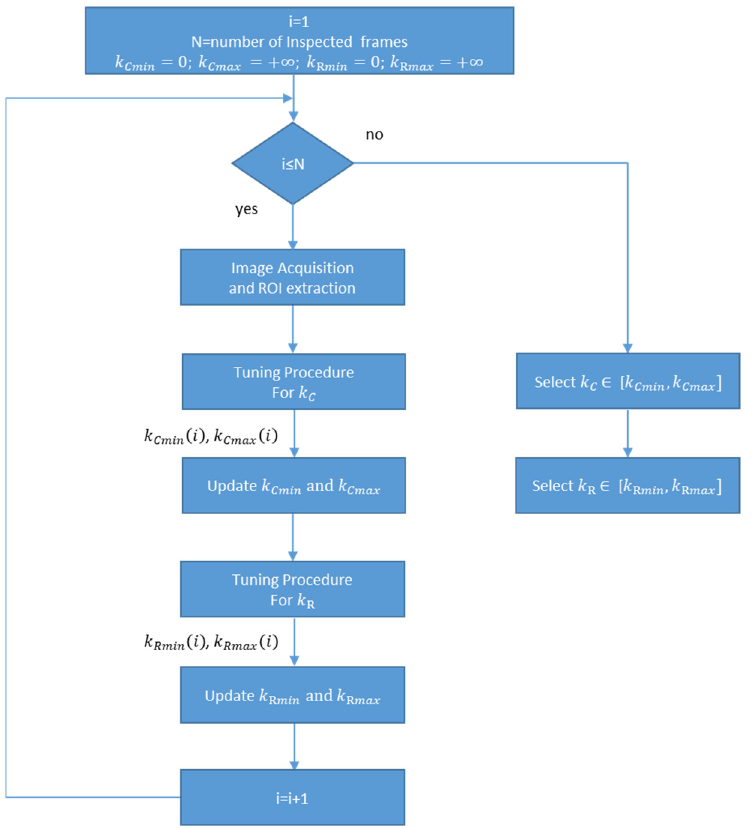
Figure 13. Flowchart of the tuning procedure. N frames are inspected, and the tuning procedure for k C and k R parameters are executed for each